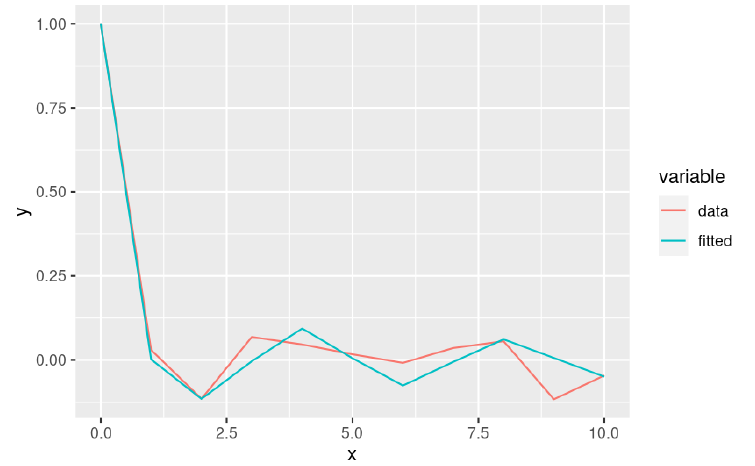
Figure 5. Autocorrelation of the intraday futures log returns, from 28 April 2022 to 18 May